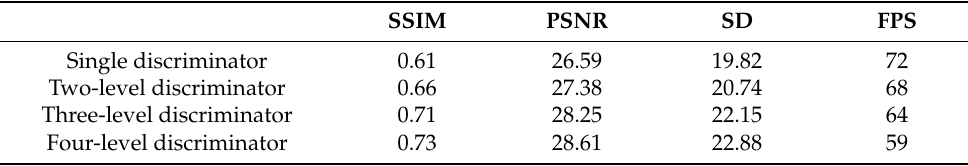
Table 8. Comparison of the effectiveness of the discriminant networks.